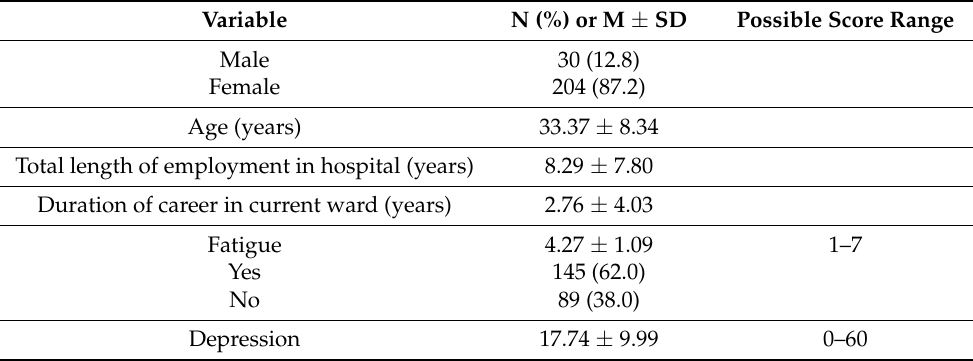
Table 1. Participants Characteristics (N =